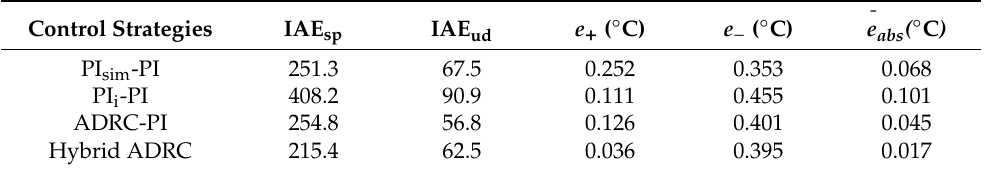
Table 8. Experimental dynamic indices of di ff erent control